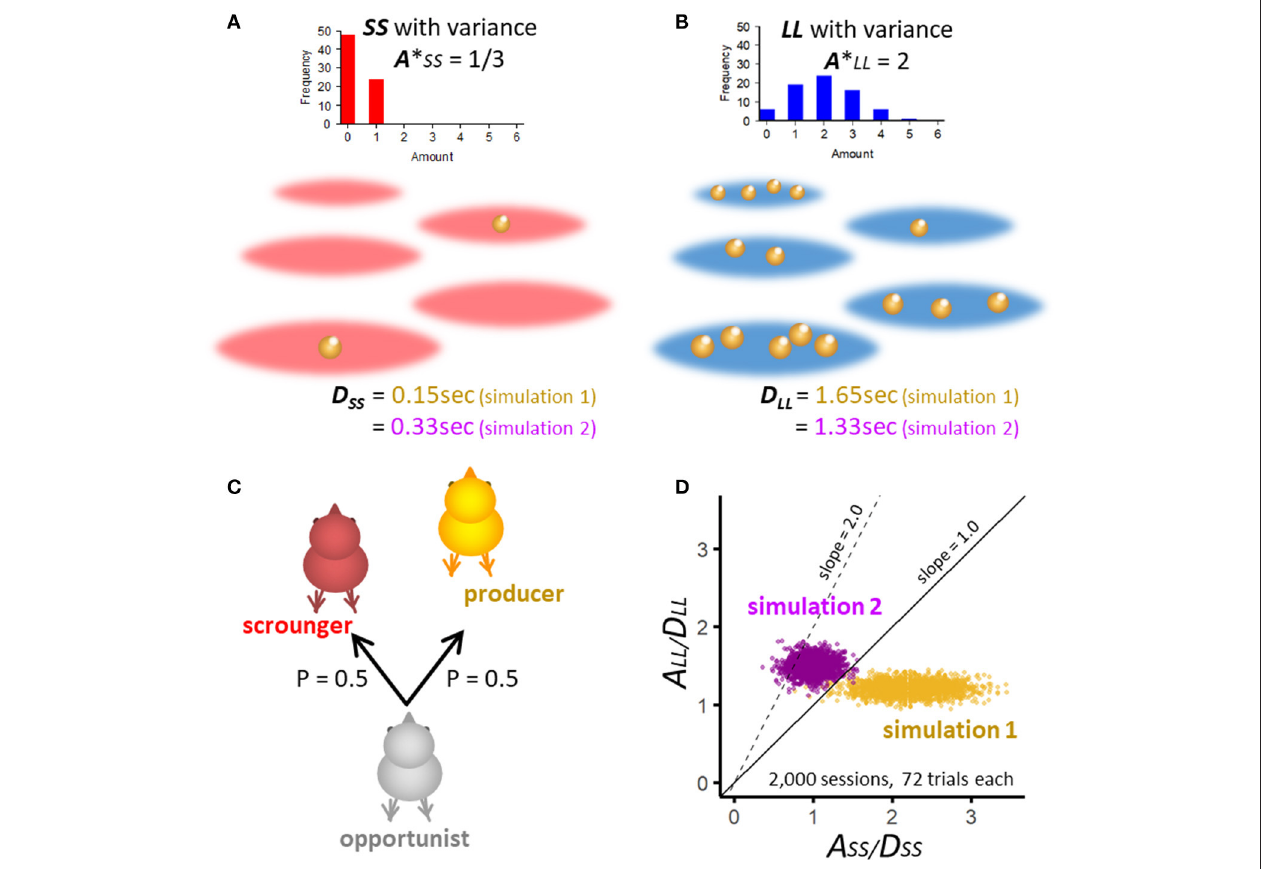
FIGURE 4 | Assumptions of numerical simulation constructed for realistic situations for SS (A) and LL patches (B) . For each patch, forager waits for a constant delay time, namely 0.15s for SS and 1.65s for LL . To mimic natural food patches, the amount of food items varies randomly according to binomial distribution. The expected amount of food was set as 1/3 for SS and 2 for LL , so that the latter is 6 times larger. (C) Opportunistic forager act producer or scrounger at equal probability = 0.5 in a manner independent from the food amount variations. (D) A / D ratio of randomly generated SS and LL pairs in 2,000 simulated sessions (each composed of 72 trials) are plotted for two sets of simulations. In simulation 1, A / D ratio is distributed mostly in the area where A SS /D SS is larger than A LL /D LL . In simulation 2, A / D ratio of LL is higher than SS and lies mainly below the line with slope = 2, corresponding to Case (2) of Figure 3